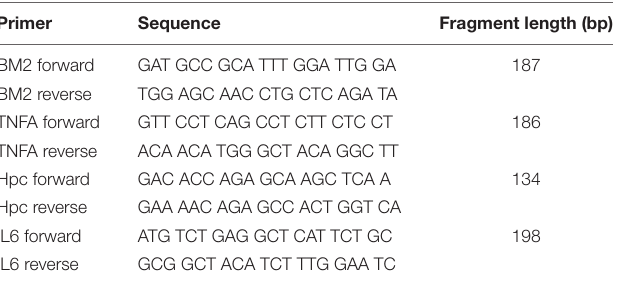
TABLE 1 | Primers for quantitative real-time